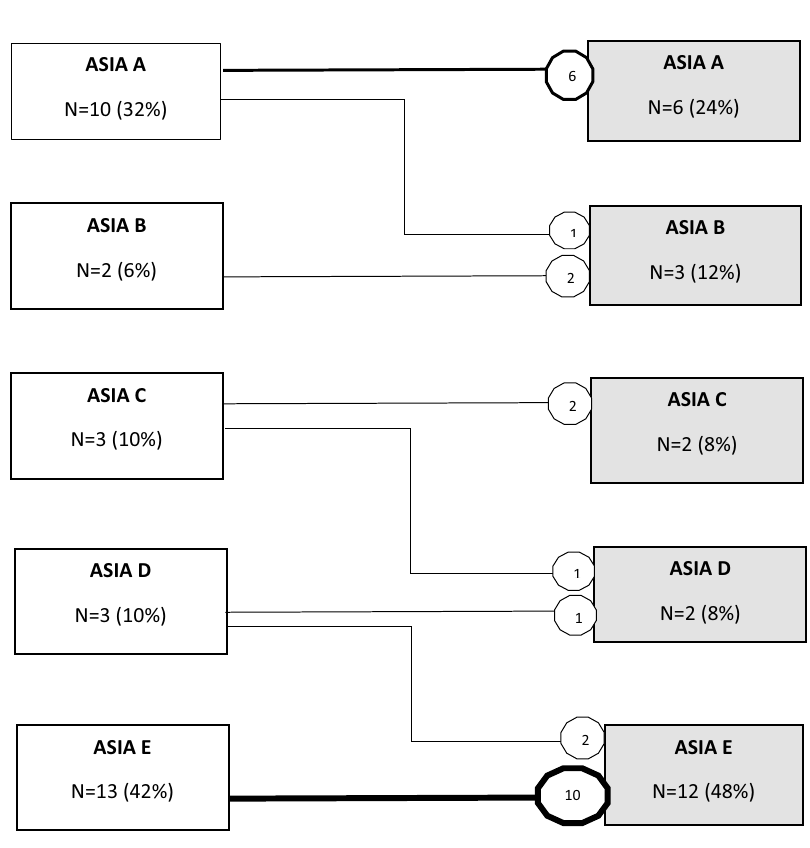
Figure 3. Spinal cord injury severity; relation between ASIA score on arrival and during last